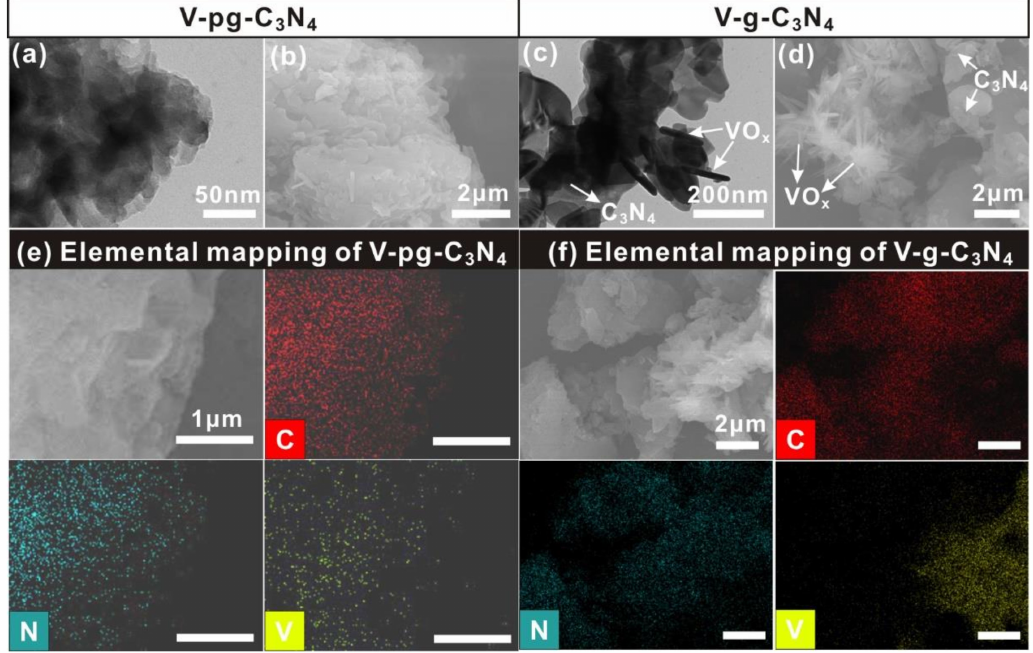
Figure 3. TEM ( a ) and SEM ( b ) images of V-pg-C 3 N 4 -0.46; TEM ( c ) and SEM ( d ) images of V-g-C 3 N 4 . Elemental mapping of V-pg-C 3 N 4 -0.46 ( e ) and ( f ) V-g-C 3 N 4